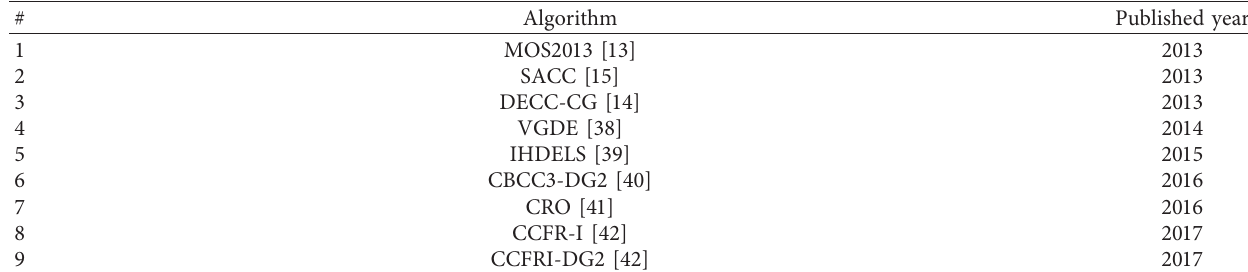
Table 5: Compared algorithms using